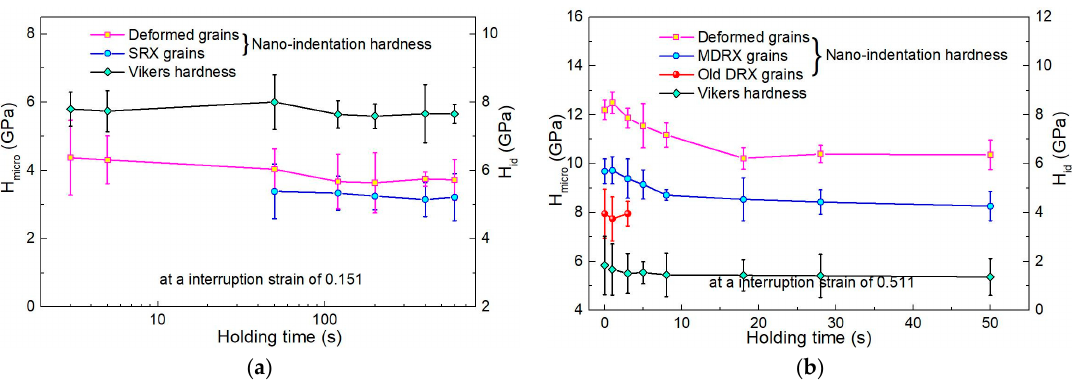
Figure 8. Variation of average Vickers hardness and indentation hardness with the holding time corresponding to: ( a ) sample A; ( b ) sample B. Data points corresponded to average values from 160 measurements for recrystallized grains and 48 measurements for deformed grains, and error bars corresponded to one standard deviation about the mean values.